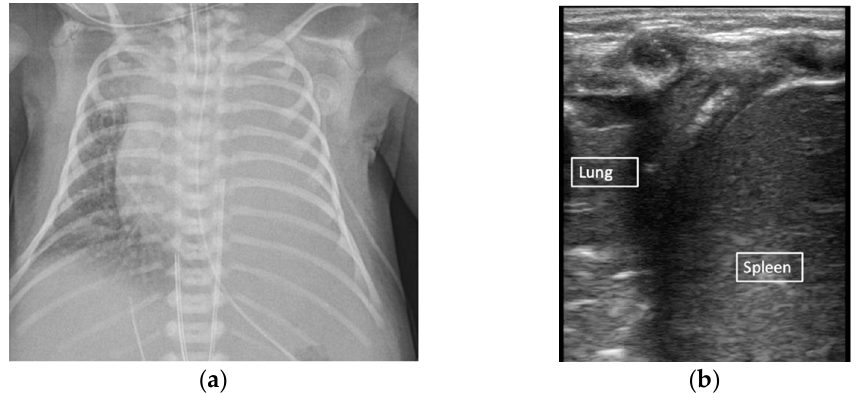
Figure 5. Effusion vs complete atelectasis. Large effusion suspected on chest X-ray ( a ). B-mode demonstrating complete atelectasis of the left lung without large pleural effusion ( b ).